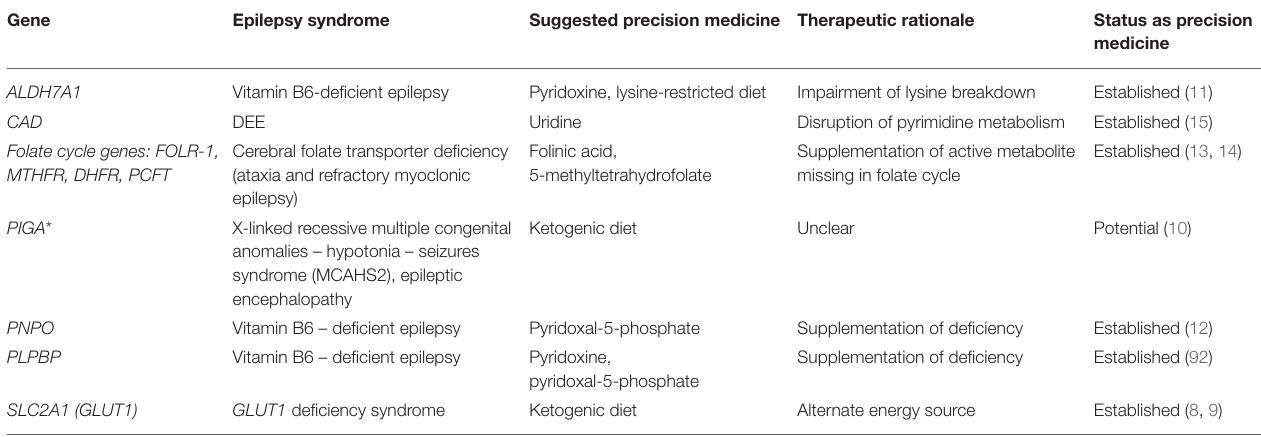
TABLE 1 | Diet and vitamins for monogenic epilepsy.